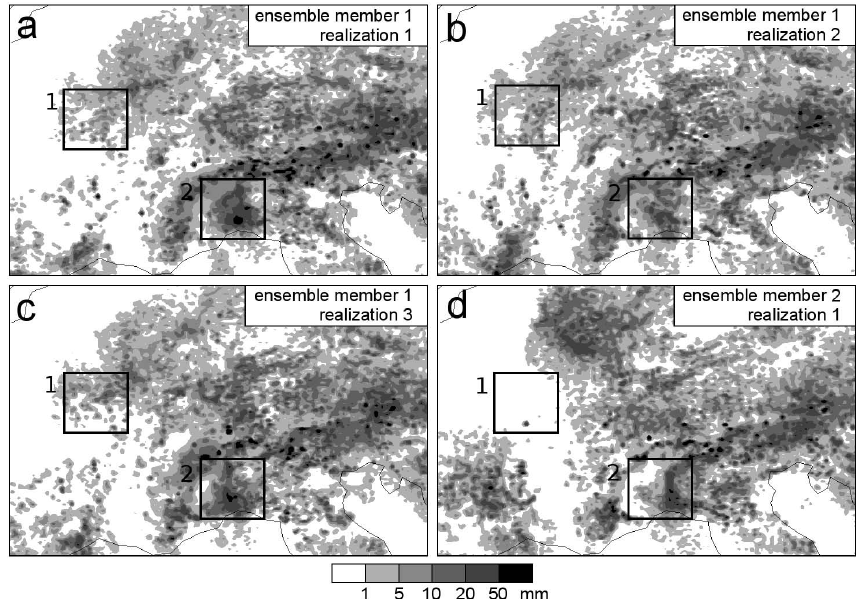
Fig. 4. 48-h accumulated rainfall of four realizations of the PC-scheme across part of the domain centered on the western Alps. Panels (a) , (b) and (c) are simulations run with intial and boundary conditions provided by the same EPS ensemble member (1), panel (d) is a simulation driven by another member (2). Squares 1 and 2 denote regions discussed in the